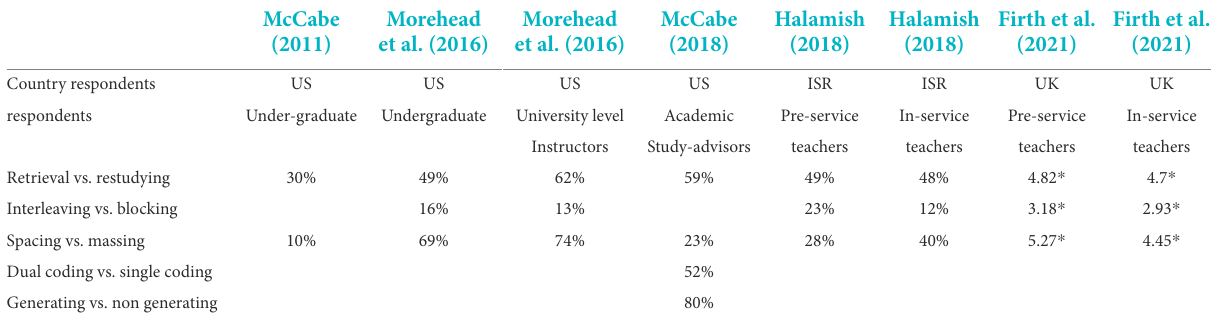
TABLE 2 Metacognitive judgments of learning strategies using